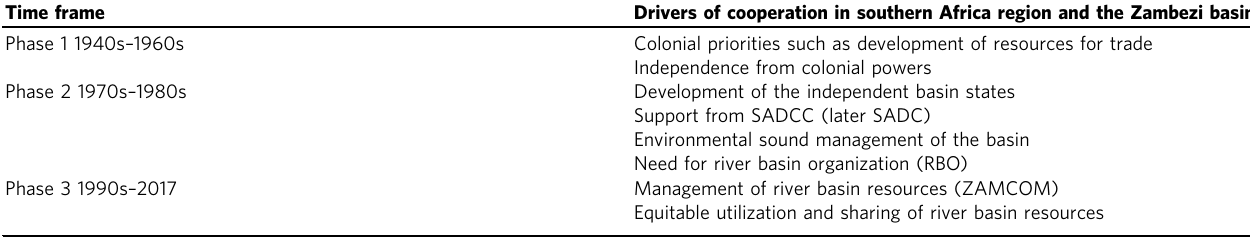
Table 1 Drivers of cooperation in the southern African region and the Zambezi basin over